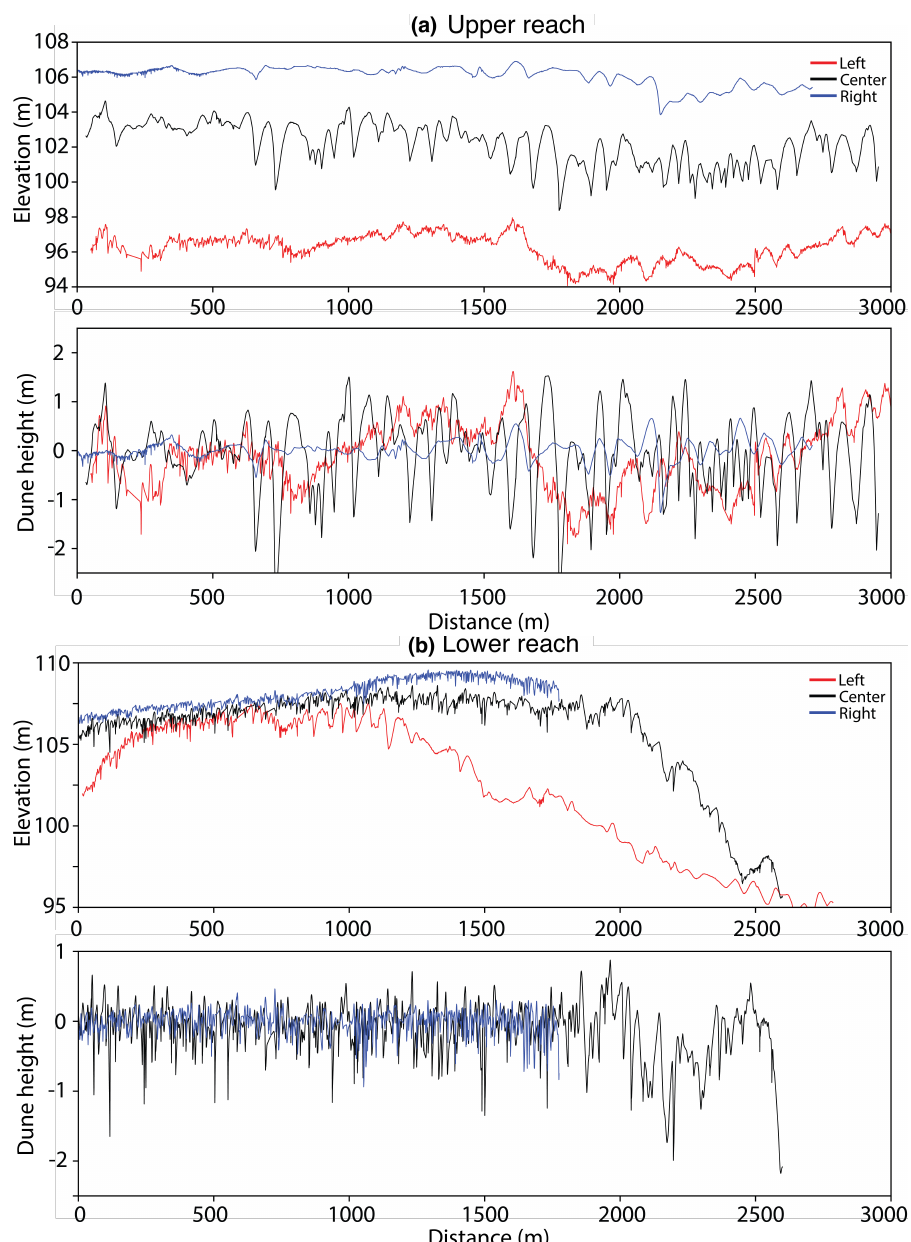
Figure 10. Bathymetry and dune height along three longitudinal profiles (left, center, and right) and dune heights (m) for: ( a ) upstream reach, ( b ) downstream reach (see Figure 9). The discretization of bedforms was obtained by using [36]’s